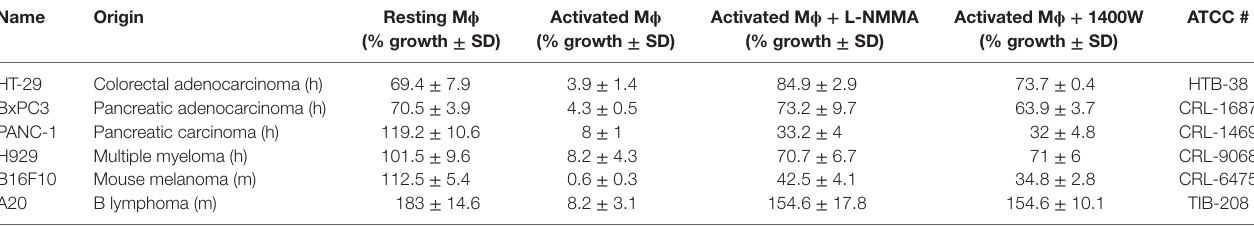
TaBle 1 | iNOS-dependent killing of human and murine tumor cell